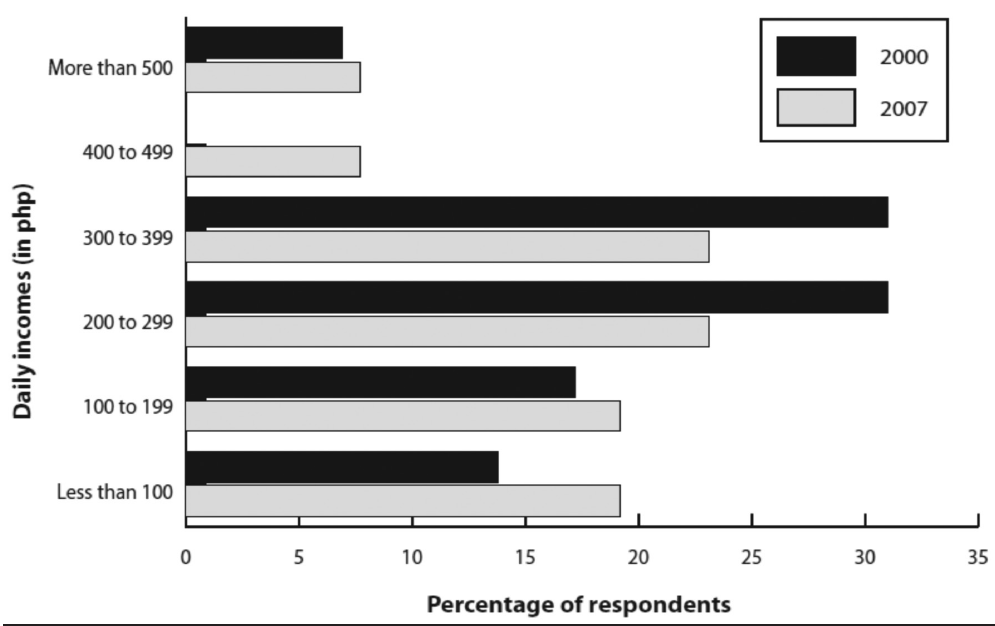
Fig 5. Daily incomes of surveyed households affected by the July 2000 trashslide in Kasiglahan – n=30 - in 2000 and 2007 – Note: 45 php = ~1US$